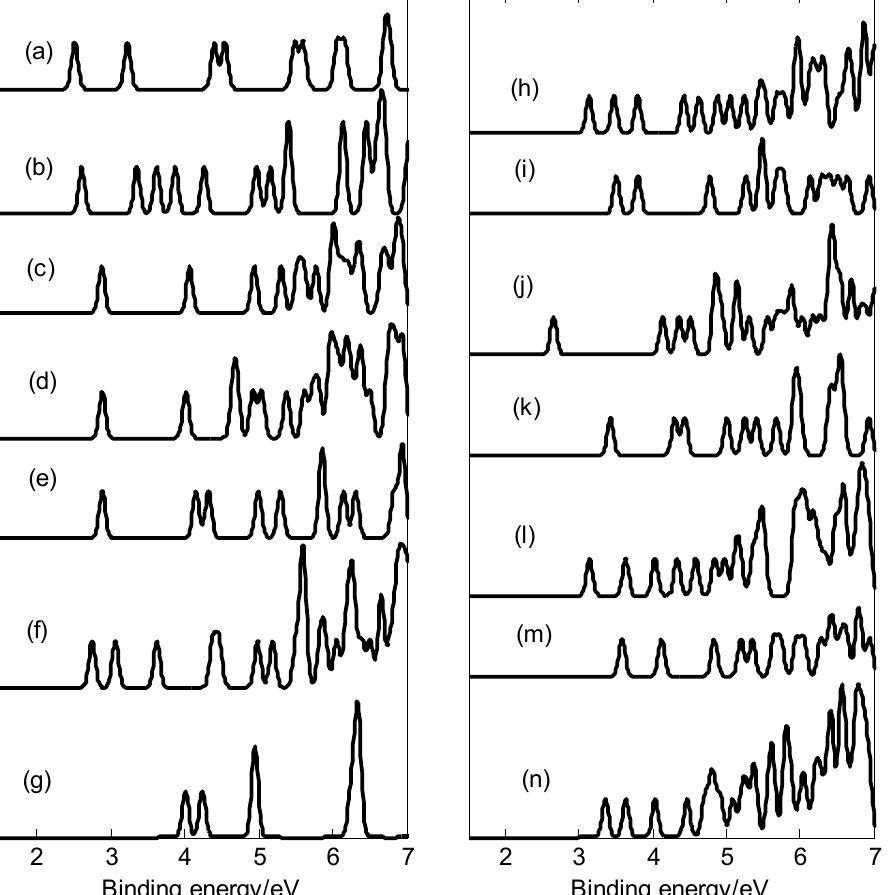
Figure 6. Photoelectron spectra at the PBE0/6-311 + G * level. ( a ) SeB 3 − ; ( b ) SeB 4 − ; ( c ) SeB 5 − ; ( d ) SeB 6 − ; ( e ) SeB 7 − ; ( f ) SeB 8 − ; ( g ) SeB 9 − ; ( h ) SeB 10 − ; ( i ) SeB 11 − ; ( j ) SeB 12 − ; ( k ) SeB 13 − ; ( l ) SeB 14 − ; ( m ) SeB 15 − ; ( n ) SeB 16 − .